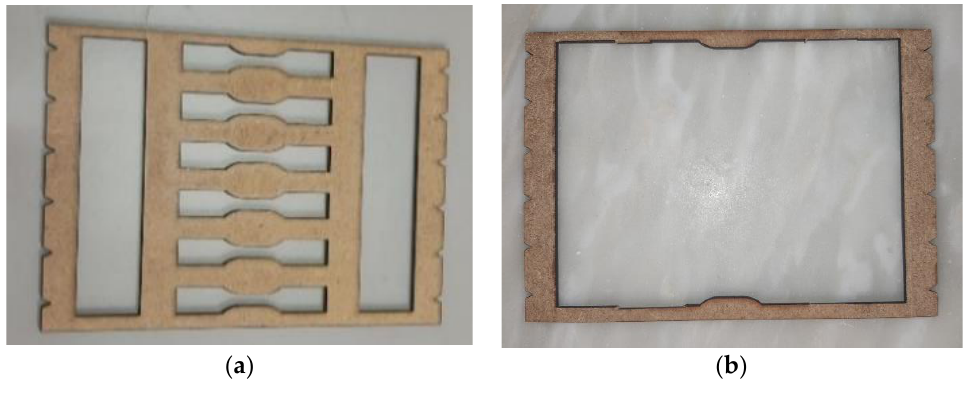
Figure 2. Molds used for tensile specimens ( a ) and flexural specimens ( b ).